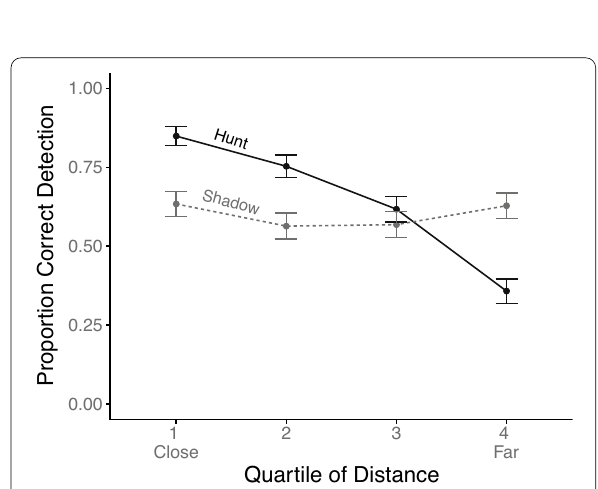
Fig. 3 Detection accuracy as a function of behavior and starting distance between the usership and hostile ship, divided into quartiles. Error bars represent one standard